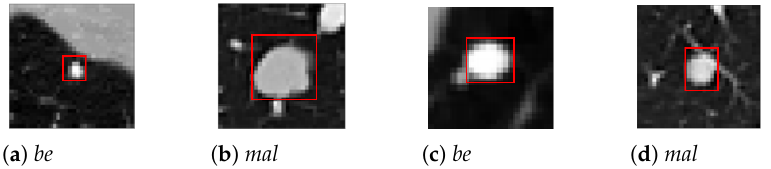
Figure 1. Visualizations of different samples in LIDC-IDRI dataset. be and mal represents benign and malignant,